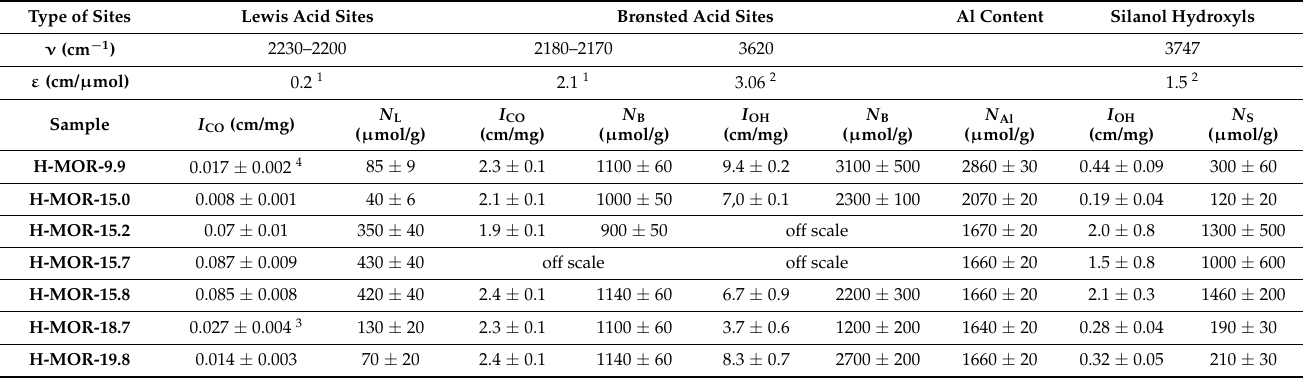
Table 5. Band intensities of adsorbed CO I CO and hydroxyl groups I OH , type and concentration N of active sites according to FTIR spectra, extinction coefficient values ε used to estimate N and quantity of Al atoms for the samples pretreated at 450 ◦